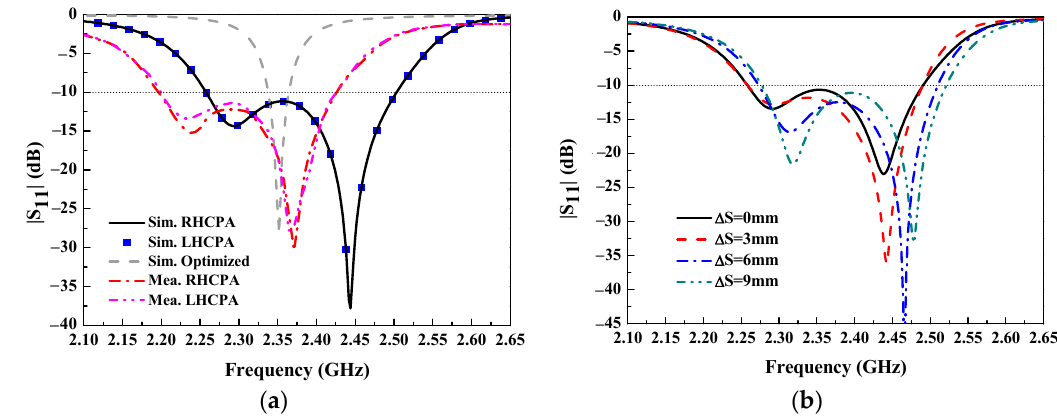
Figure 7. ( a ) Simulated and measured reflection coefficients of the optimized EPA, the RHCPA, and the LHCPA; ( b ) effect of inversely offsetting SSRs by equal distance ( Δ S) on the reflection coefficients LHCPA; ( b ) effect of inversely offsetting SSRs by equal distance ( ∆ S) on the reflection coefficients of of the RHCPA. the